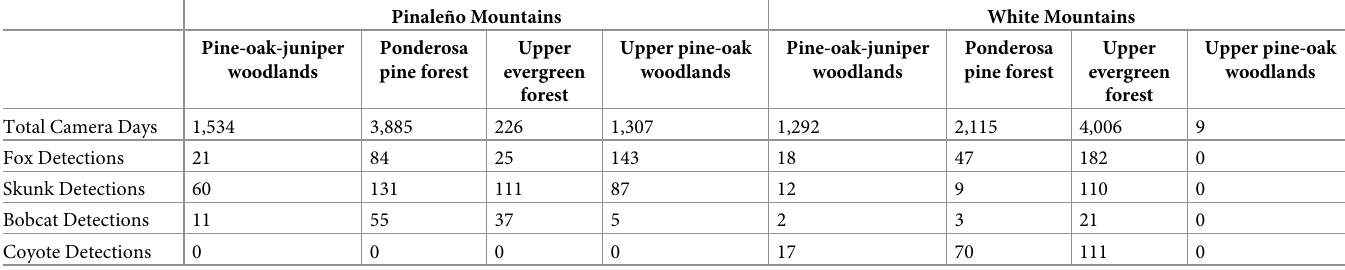
Table 3. Species detections across sampling